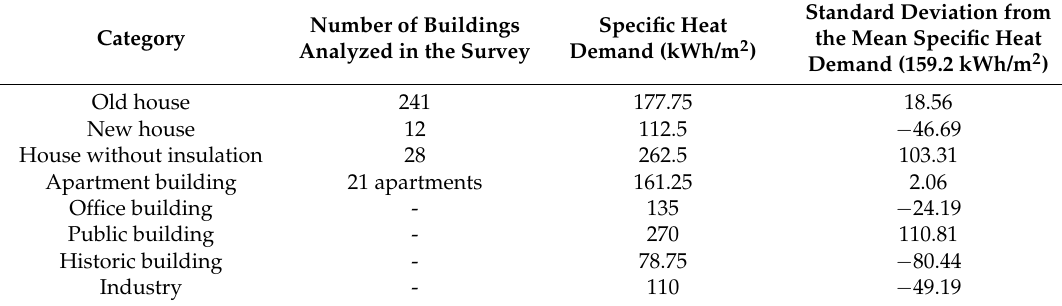
Table 1. Building categories and associated specific heat